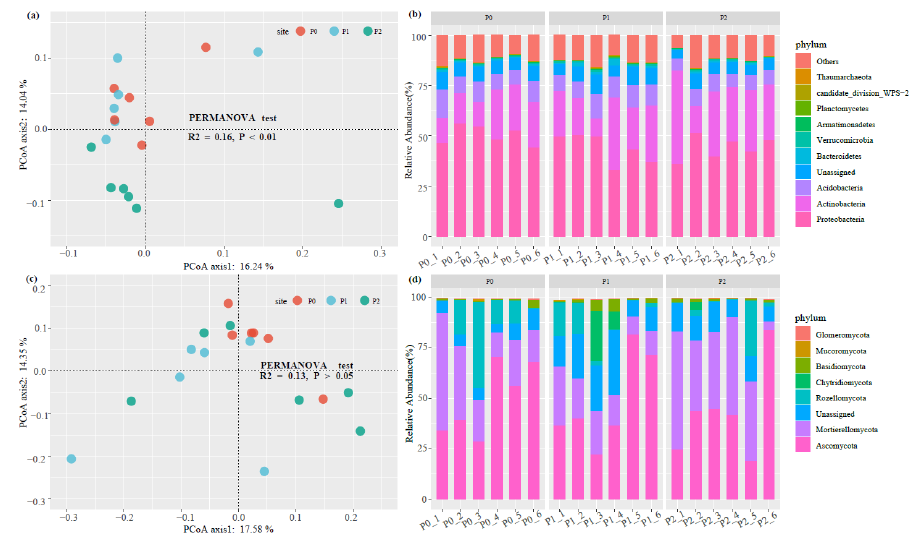
Figure 2. Rhizosphere microbial community structure changes under different treatments: ( a ) bacterial PCoA plot, ( b ) the relative abundance of bacteria at the level of top ten phyla, ( c ) fungal PCoA plot, and ( d ) the relative abundance of fungi at the level of top eight phyla. Replicates in each treatment were six. The rhizosphere bacterial community composition revealed that Proteobacteria (mean relative abundance, MRA: 46.21%), Actinobacteria (MRA: 23.45%) and Acidobacteria (MRA: